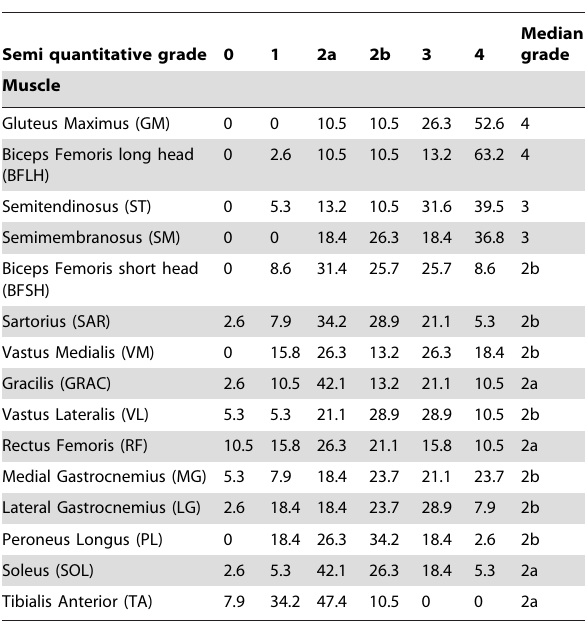
Table 2. Percentage of LGMD2I patients in each category of each semi-quantitative grade for individual muscle groups using the Mercuri et al. scale, with the median grade for each muscle.